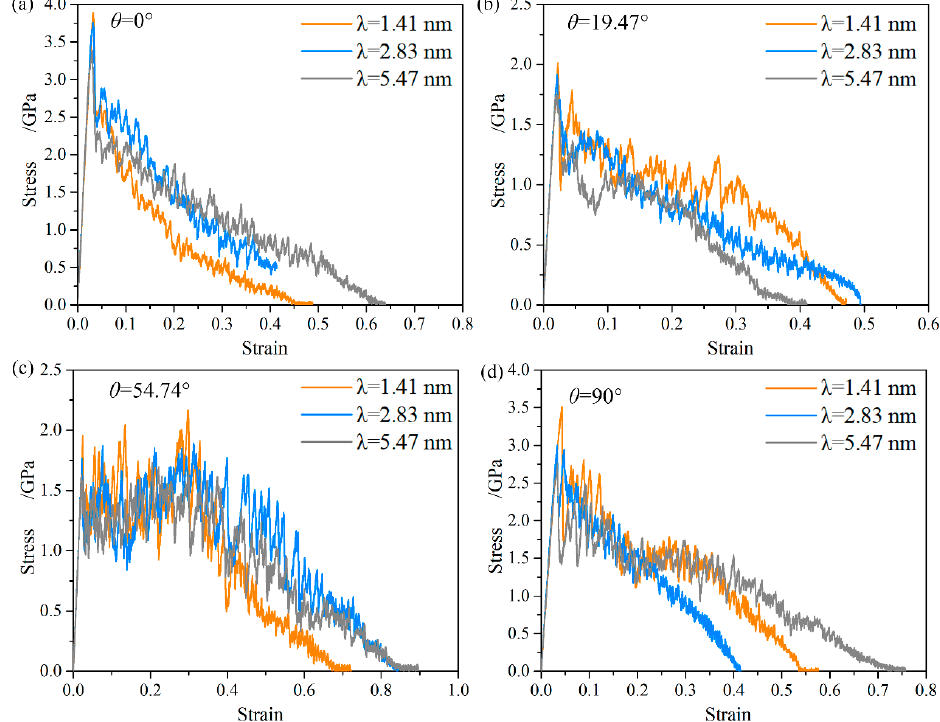
Figure 4. Engineering stress-strain curves of the NT Au nanowires with different twin orientation and twin spacing. ( a ) θ = 0°, ( b ) θ = 19.47°, ( c ) θ = 54.74°, and( d ) θ = 90°.